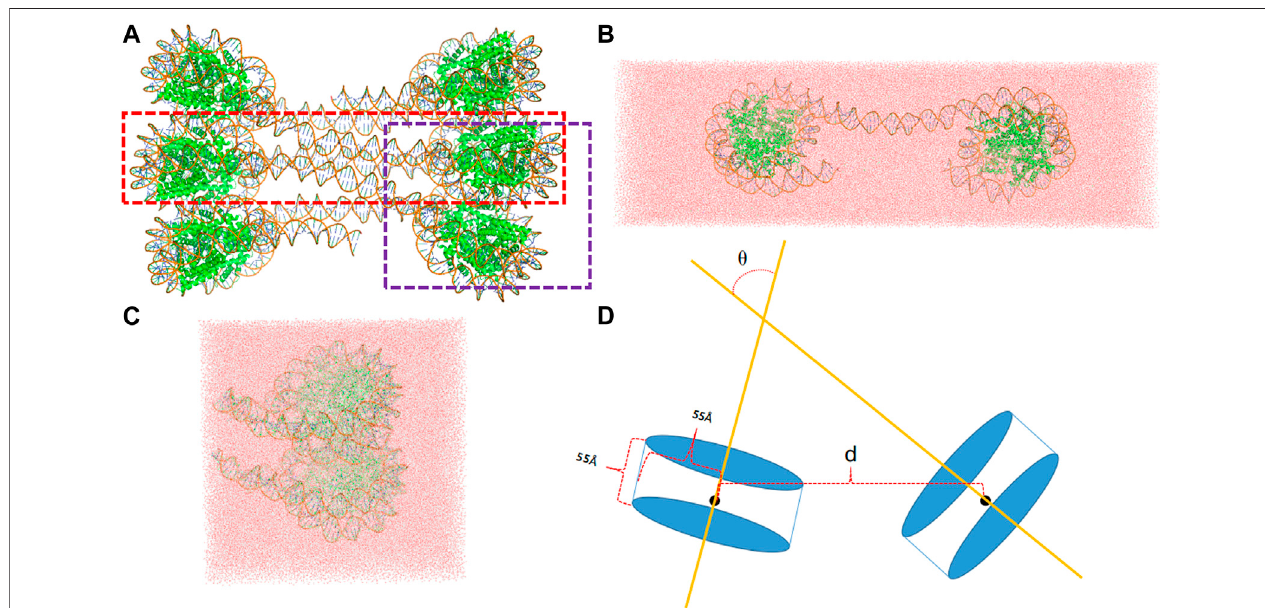
FIGURE1|(A) Thetemplatestructure(pdbid:6hkt)forthesetupofsimulationsystemincludessixnucleosomeswitha fl attwo-starthelixwithuniformnucleosomal stacking interfaces and an uncondensed nucleosome packing density. The LN system is marked by a red rectangle, whereas the ULN by a purple rectangle. (B) A snapshot of the LN system after 10 ns MD simulation. (C) A snapshot of the ULN system after 10 ns MD simulation (D) The distance, d , de fi ned using the centers of nucleosomes and the angle, θ , de fi ned using the superhelical axes of